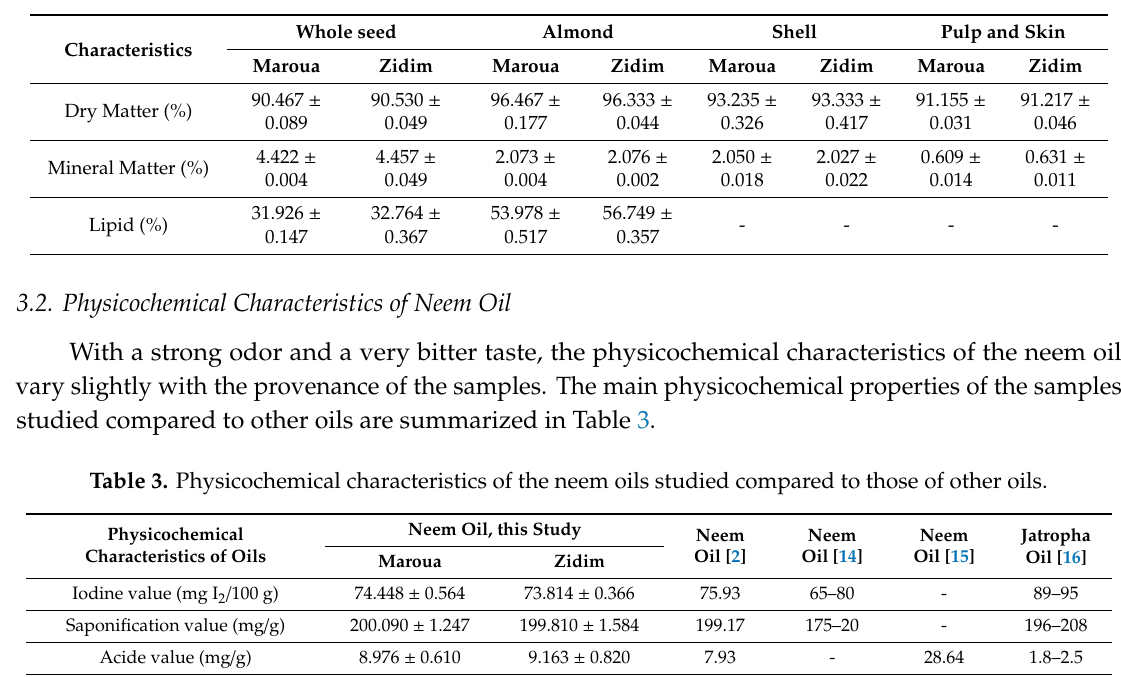
Table 2. Percentage distribution of the main constituent elements of neem seeds.